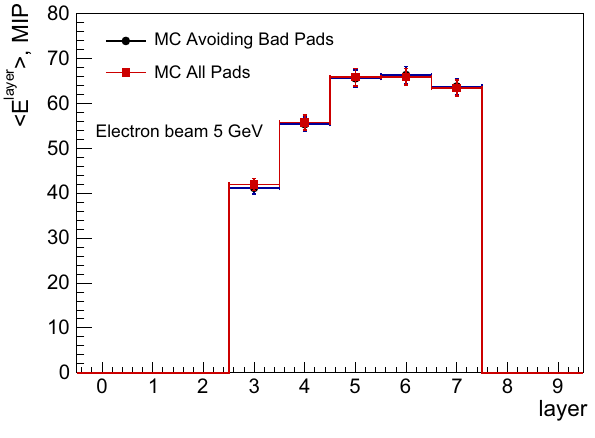
Fig. 20 Longitudinal shower profile, comparison between data and simulation. The distributions are obtained with a 5 GeV electron